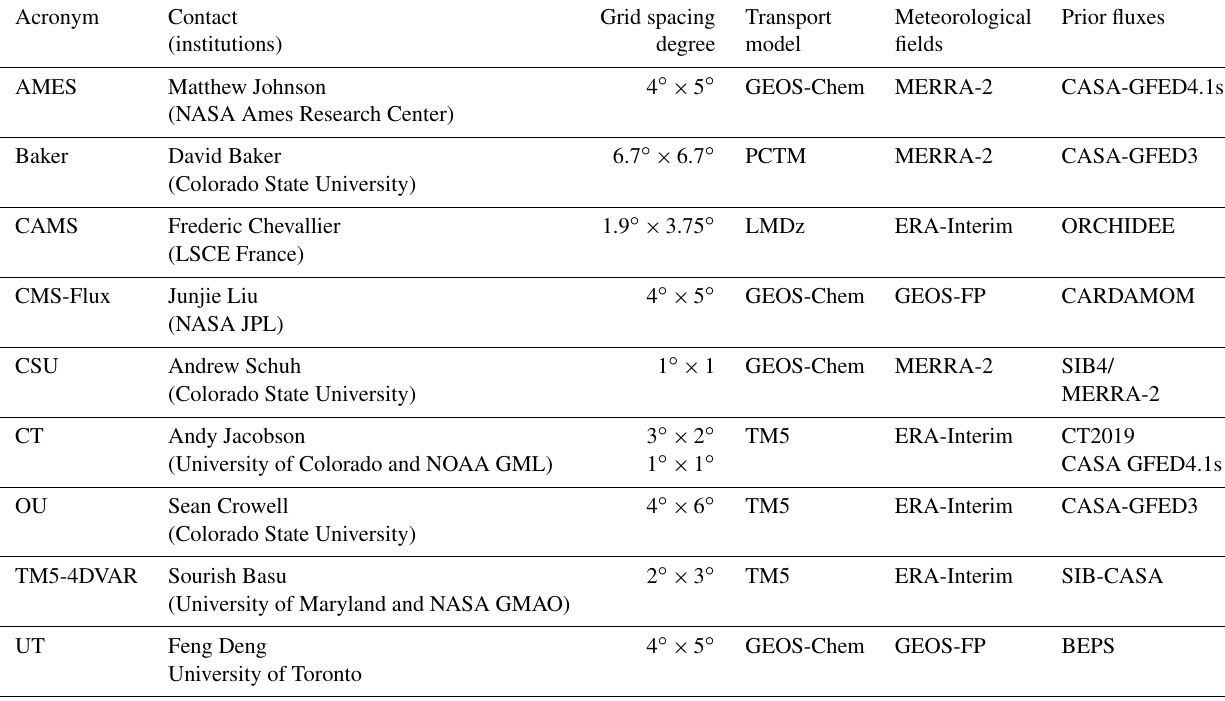
Table 3. Summary of the configuration of the OCO-2 MIP (version 9)